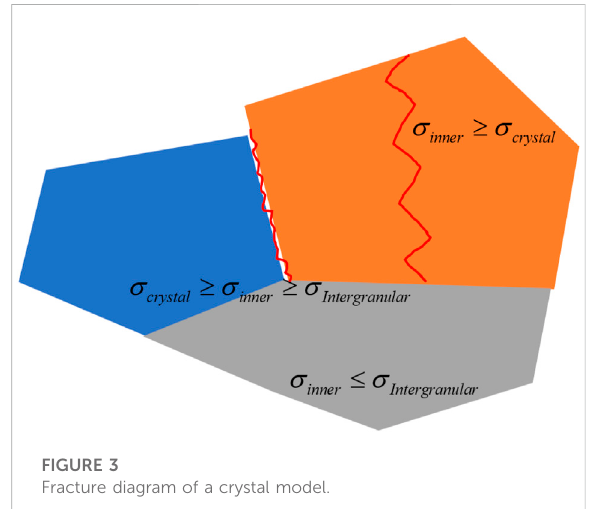
FIGURE 3 Fracture diagram of a crystal